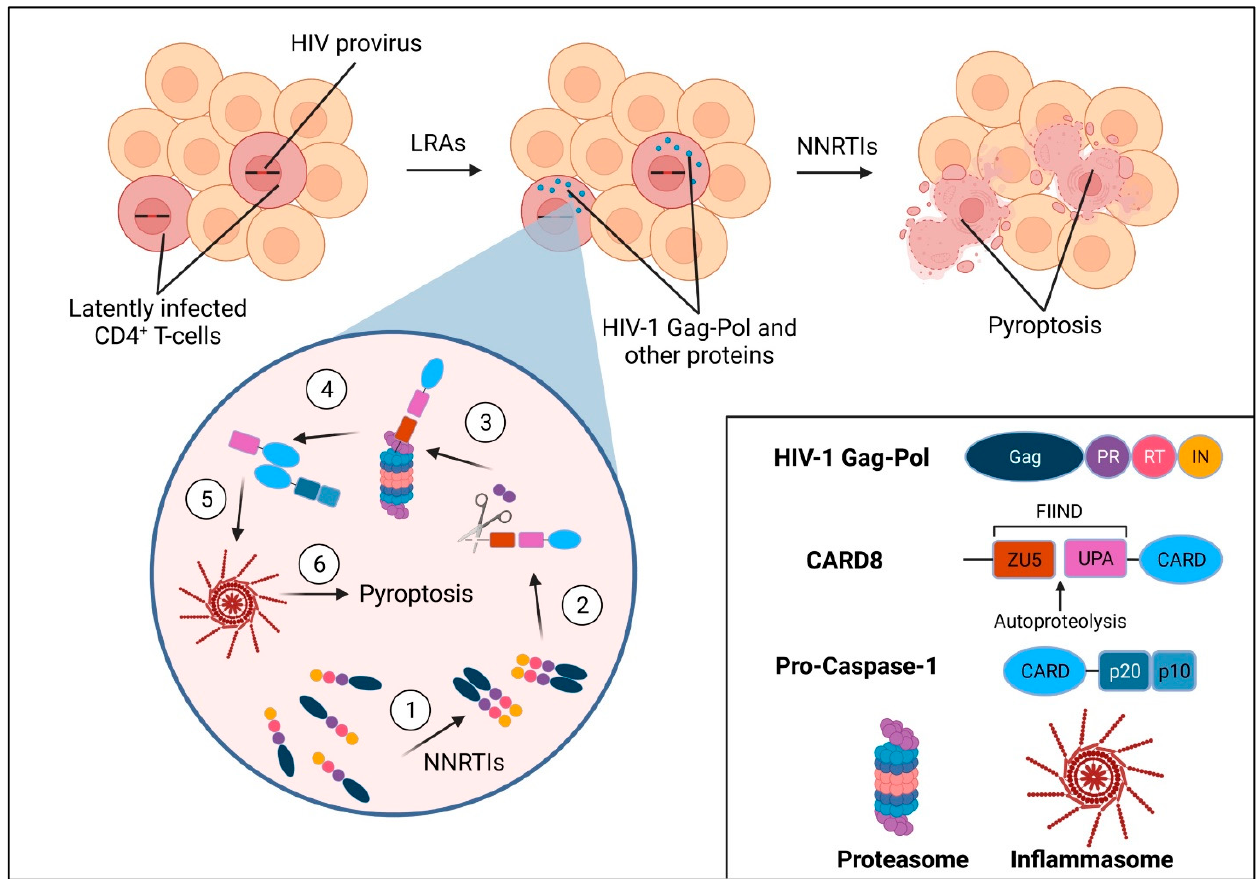
Figure 1. The shock and kill scheme using targeted CARD8 activation. Latency reversal agents (LRAs) are used to reactivate viral gene transcription in latently infected resting memory CD4 + T cells, leading to production of HIV Gag-Pol polyprotein and other viral proteins. The treatment with non-nucleoside reverse transcriptase inhibitors (NNRTIs) leads to Gag-Pol dimerization and premature PR activation (1). The activated PR cleaves the N-terminus of CARD8 (2), which causes the neo-N-terminus to be targeted for proteasomal degradation (3). Due to the break in the polypeptide chain between the ZU5 and UPA domains of CARD8 caused by autoproteolysis, the bioactive UPA- CARD fragment is released from the proteasome (4). The UPA-CARD fragment recruits and activates pro-caspase-1 (4), leading to downstream inflammasome assembly (5) and pyroptosis